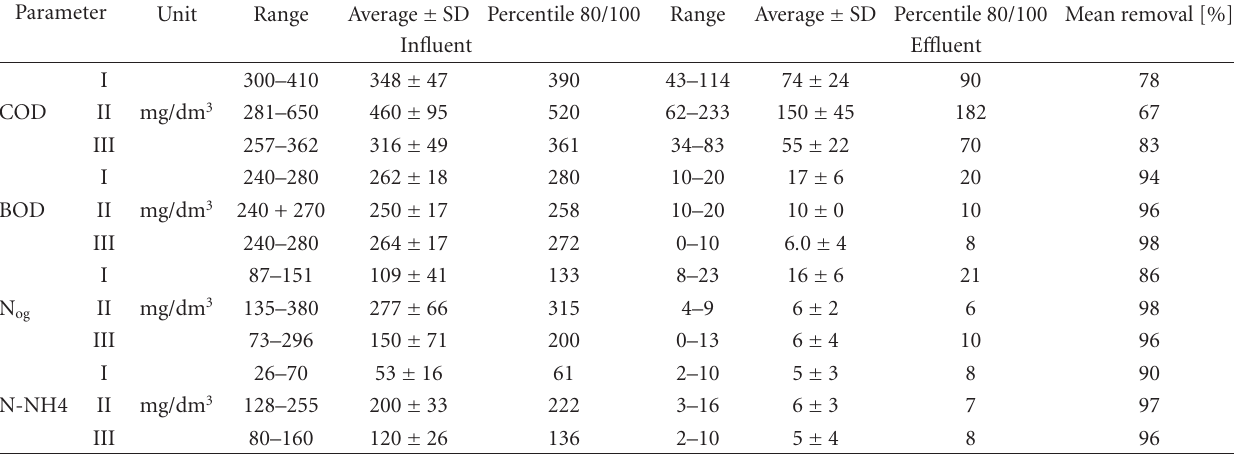
Table 6: Chemical characteristics of raw and treated wastewater (10% of leachate in influent I and II).